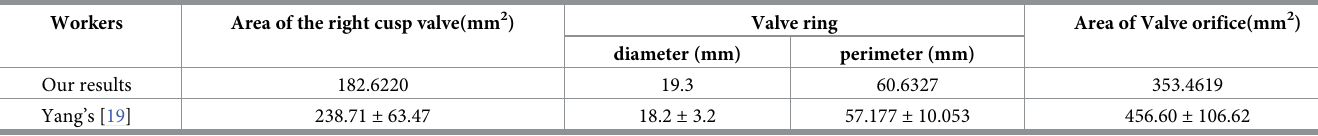
Table 2. Comparison of our values with Yang’s values [19]. Workers Our